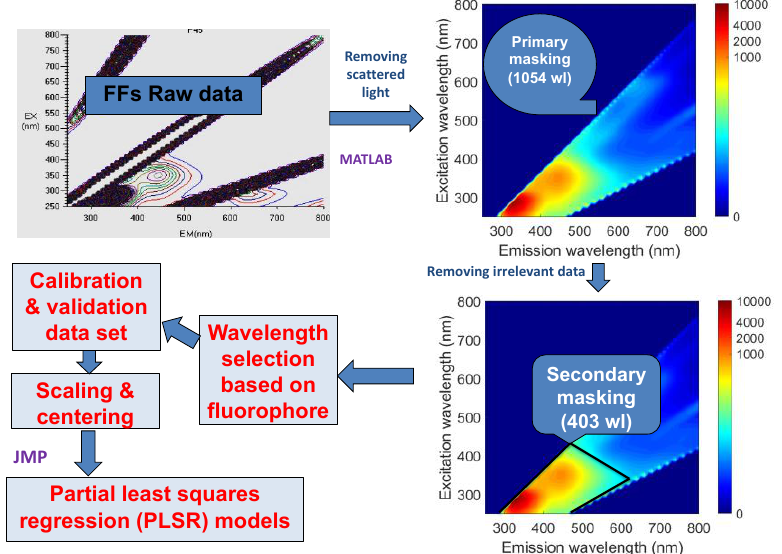
Figure 1. Scheme for preprocessing and masking of fluorescence spectra for multivariate analysis.